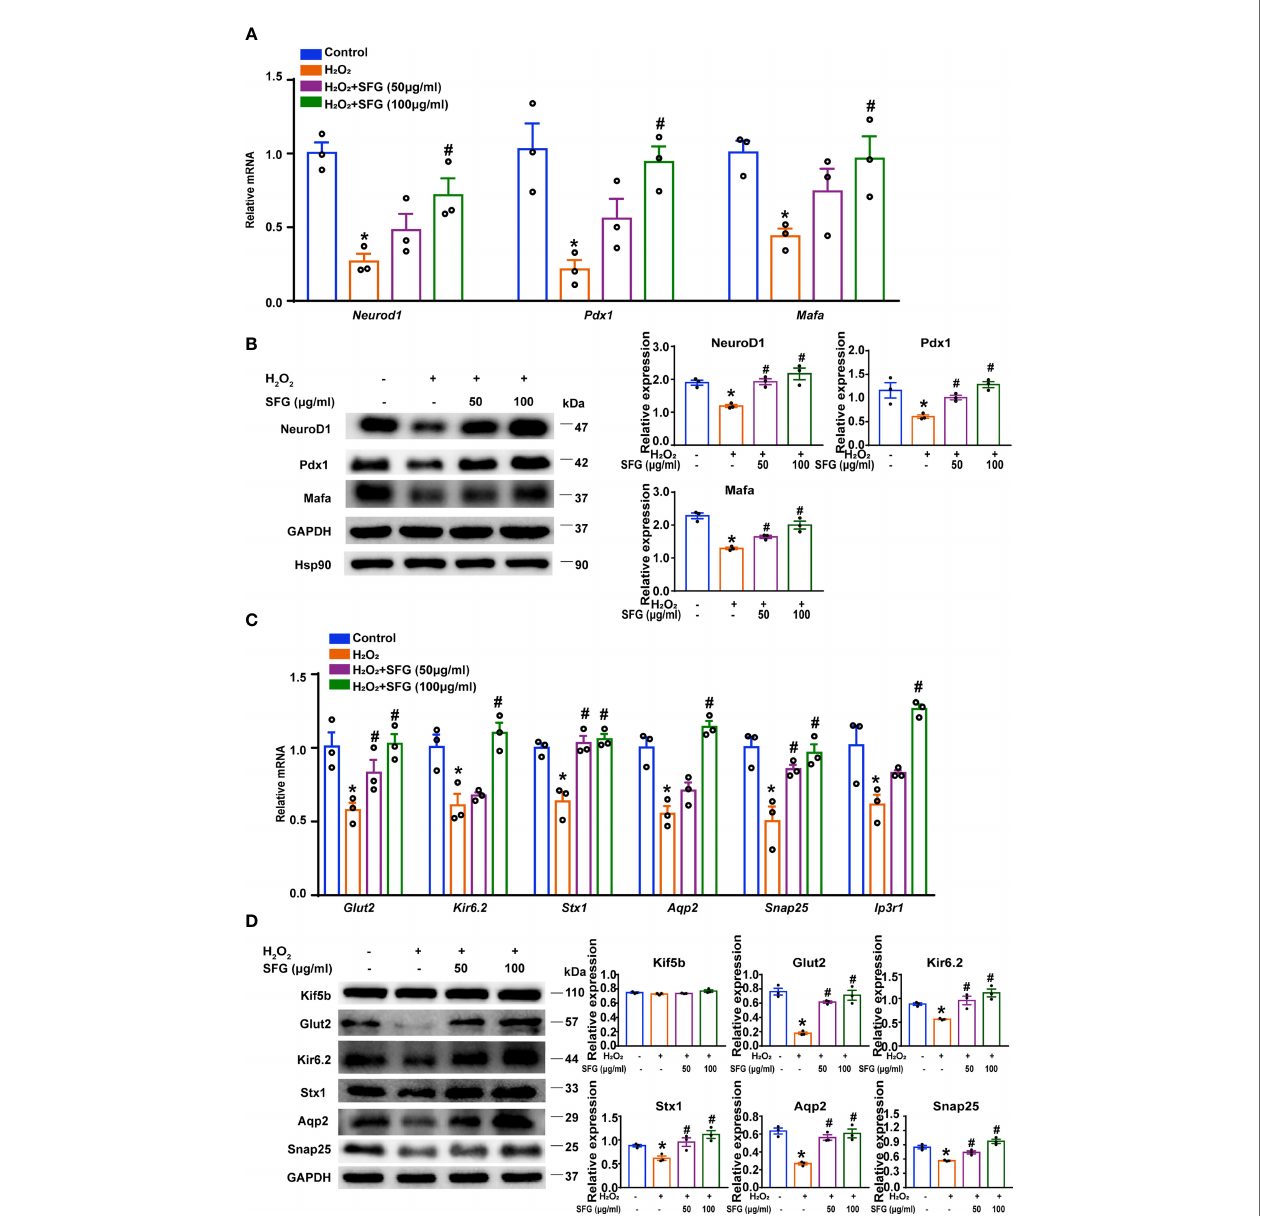
FIGURE 4 | SFG potentiated b -cell function by regulating b -cell identity and the insulin secretion-related genes and proteins of H 2 O 2 -treated MIN6 cells. (A) Neurod1 , Mafa , and Pdx1 gene expression (n=3). *P < 0.05 versus control; # P < 0.05 versus H 2 O 2 -only group. (B) Western blot of NeuroD1, Mafa, and Pdx1 (n=3). GAPDH was used as a loading control for NeuroD1 and Pdx1, Hsp90 was used as a loading control for Mafa. Densitometric analysis of the Western blot bands were shown. *P < 0.05 versus control; # P < 0.05 versus H 2 O 2 -only group. (C) Gene expression of Glut2 , Snap25 , Ip3r1 , Aqp2 , Stx1 , and Kir6.2 (n=3). *P < 0.05 versus control; # P < 0.05 versus H 2 O 2 -only group. (D) Western blot analysis of the expression of Glut2, Kir6.2, Stx1, Aqp2, and Snap25 in MIN6 cells (n=3). GAPDH was used as a loading control. Densitometric analysis of the Western blot bands were shown. *P < 0.05 versus control; # P < 0.05 versus H 2 O 2 -only